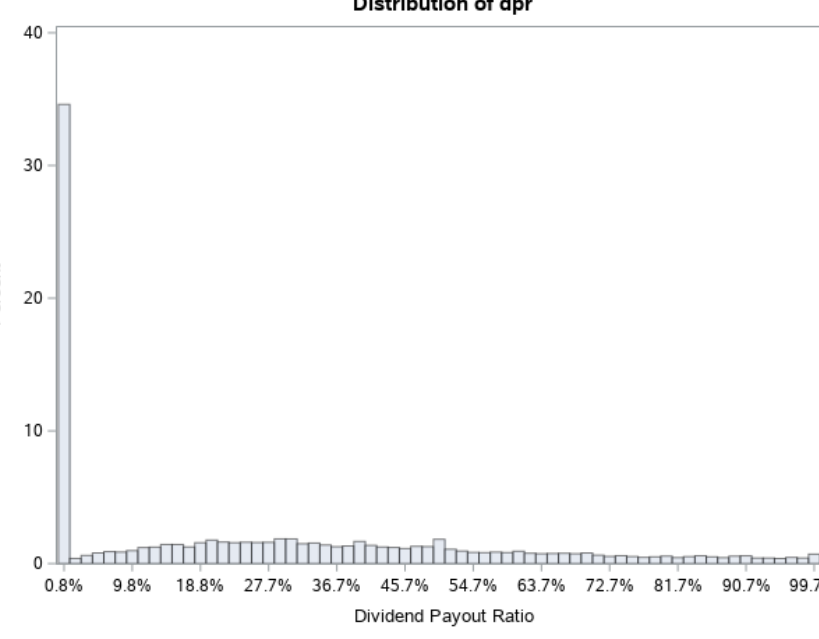
Figure 1 : Dividend payout ratio for the companies included in the sample, in the period 2008–2014. All companies’ financials were collected from the Thomson Research Worldscope database. DPR is computed as: (cid:1830)(cid:1842)(cid:1844) (cid:3404) (cid:3005)(cid:3036)(cid:3049)(cid:3036)(cid:3031)(cid:3032)(cid:3041)(cid:3031)(cid:3046) (cid:3015)(cid:3032)(cid:3047) (cid:3036)(cid:3041)(cid:3030)(cid:3042)(cid:3040)(cid:3032)